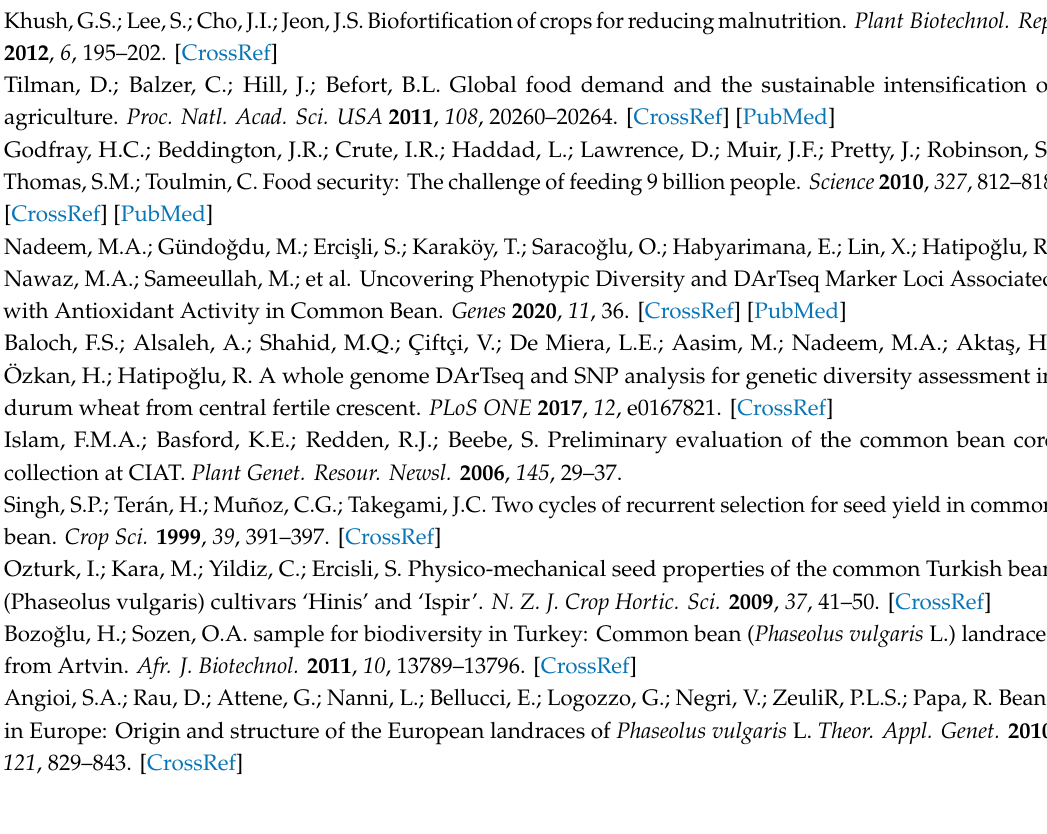
Table S1. Passport data of 183 Turkish common bean accessions. Table S2. Climatic conditions of Bolu and Sivas locations during the whole period of study. Table S3. Various agronomic and qualitative traits measured in Turkish common bean. Table S4. Adjusted means of 22 traits using five environments for Turkish common bean germplasm. Table S5. Diversity of various qualitative traits in Turkish common bean germplasm. Table S6. Eigenvalues of the first five principal component axes (PC) for the Turkish common bean